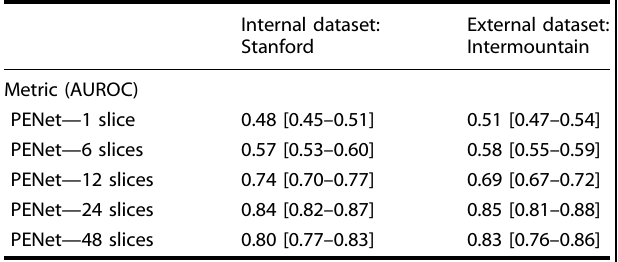
Table 4. Input slice number